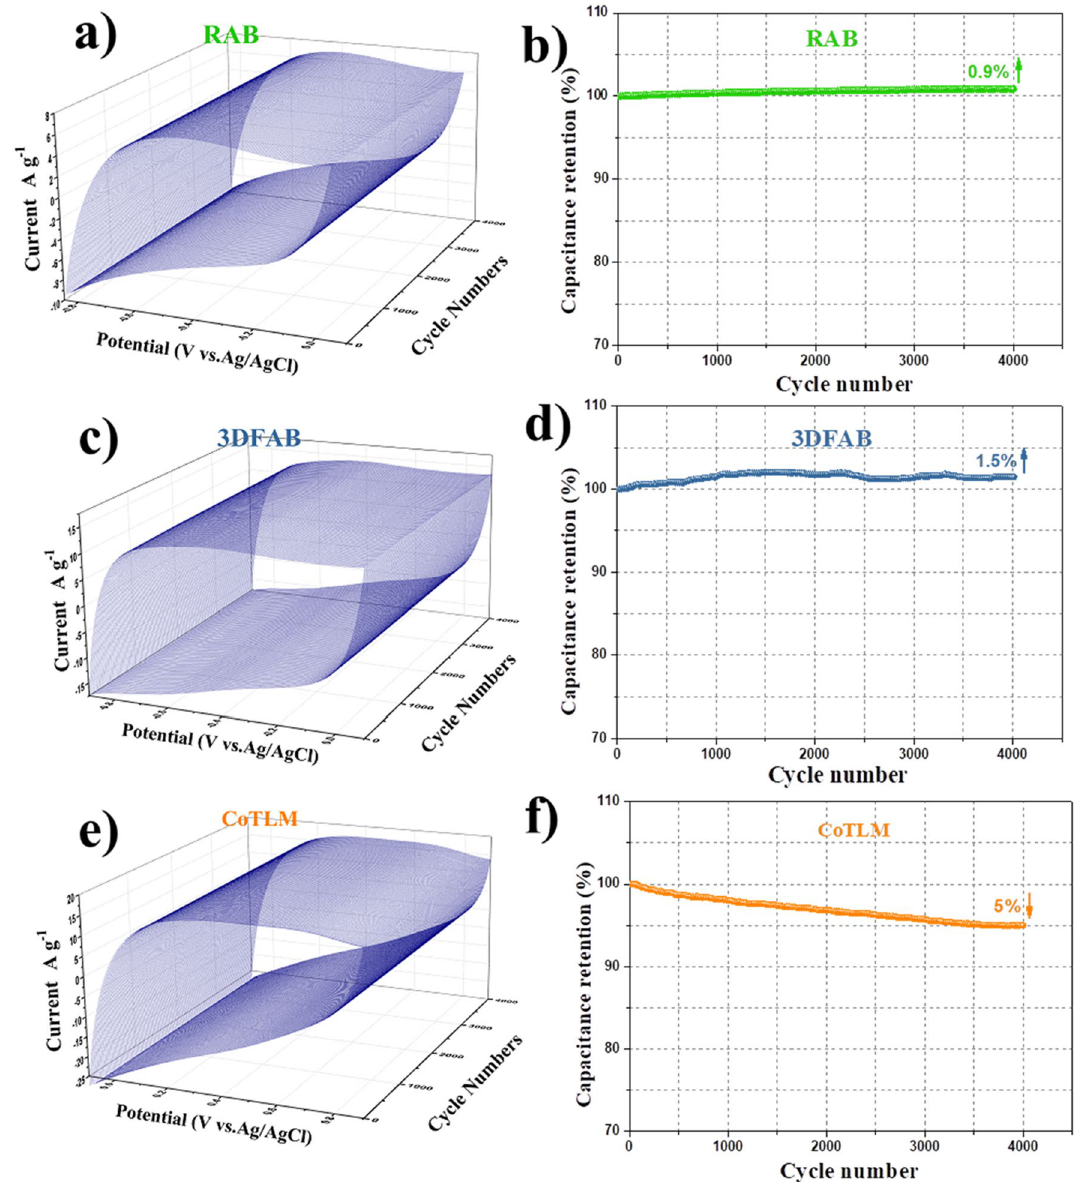
Figure 6. 3D-CCV curves of the RAB, 3DFAB, and CoTLM electrodes measured at a scan rate of 50 mV s −1 ( a – c ), variation of the specific capacitance of the RAB, 3DFAB, and CoTLM electrodes with CCV method as a function of the number of cycles at 50 mV s −1 ( d – f